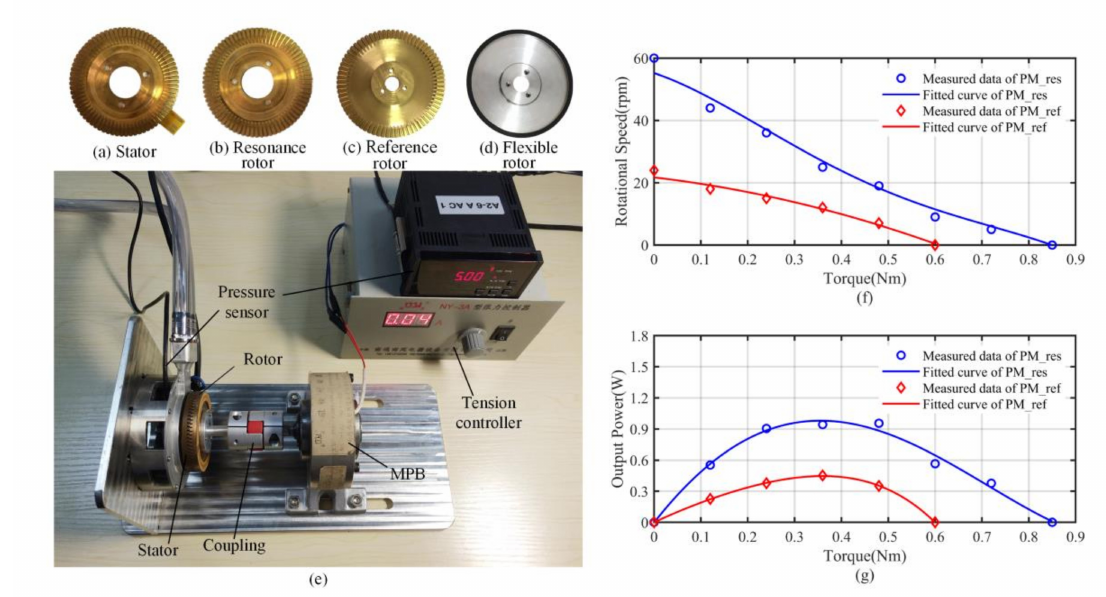
Figure 10. Prototype experiments and output performance curves. ( a ) Stator. ( b ) Resonance rotor. ( c ) Reference rotor. ( d ) Flexible rotor. ( e ) Experimental device. ( f ) Speed-torque curve. ( g ) Power-torque